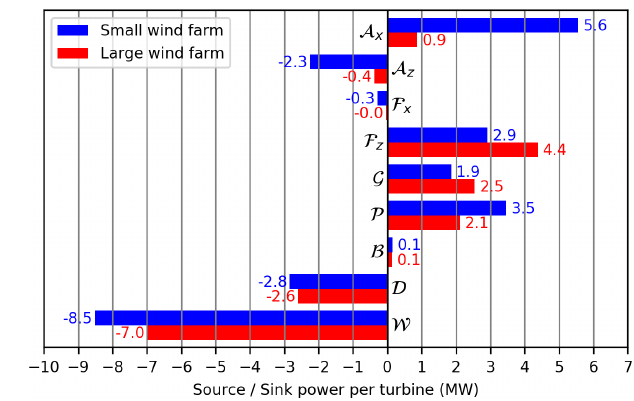
Figure 12. Energy budgets inside control volume (cid:127) wf that envelops the entire small/large wind farm. The budget terms are horizon- tal advection of KE ( A x ), vertical advection of KE ( A z ), turbu- lent fluxes through left/right ( F x ) and bottom/top ( F z ) surfaces, geostrophic forcing ( G ), perturbation pressure gradients ( P ), buoy- ancy ( B ), dissipation ( D ), and wind turbines ( W